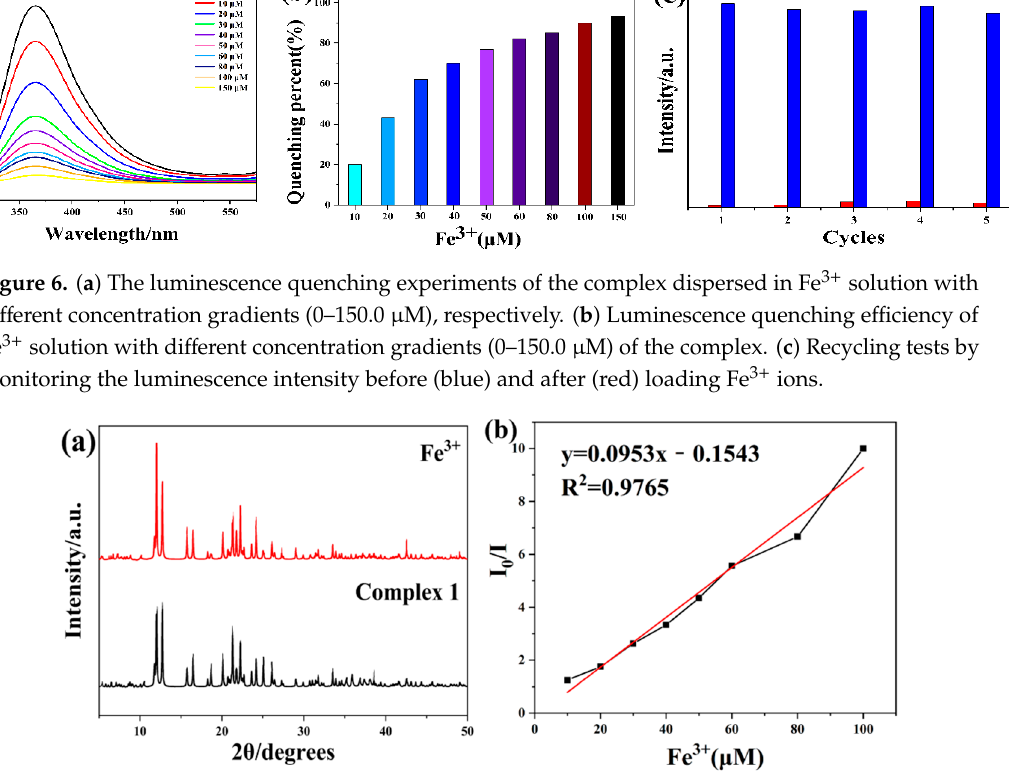
Figure 7. ( a ) The powder X-ray diffraction (PXRD) patterns of the complex before and after adsorption of Fe 3+ ions. ( b ) Stern–Volmer plot of the complex suspension quenched by Fe 3+ .